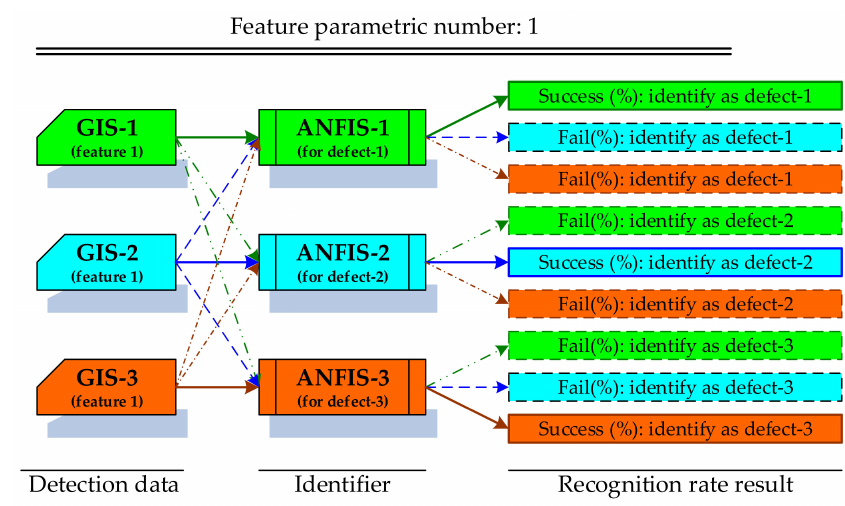
Figure 18. System architecture for testing attributable function types.